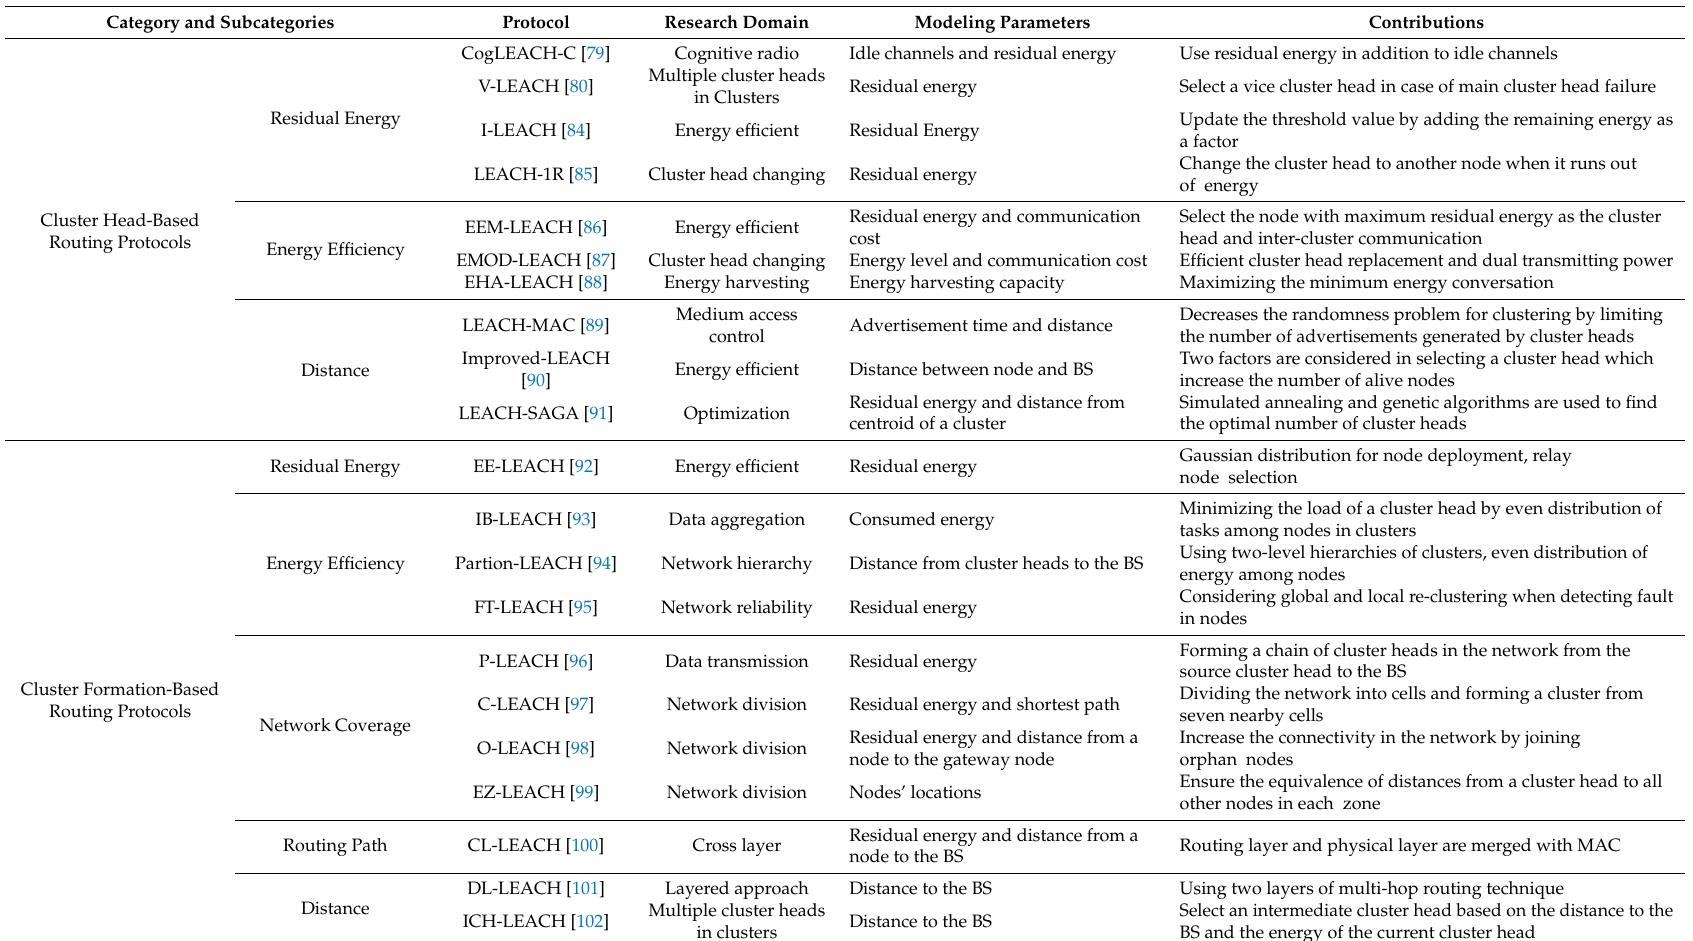
Table 10. Features of routing protocols in WSNs based on the LEACH